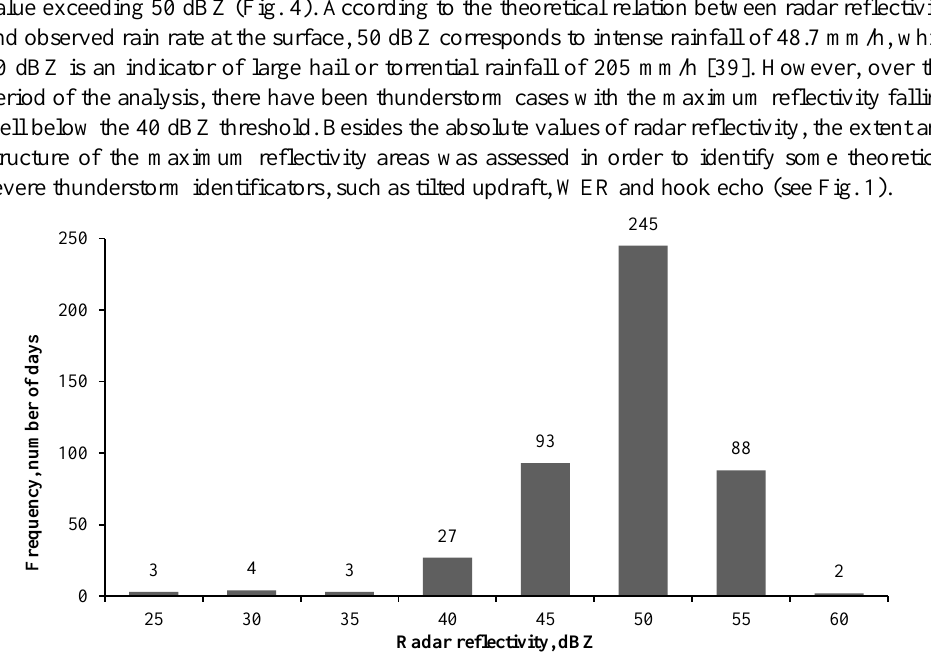
Fig. 4. The frequency distribution of reflectivity values (dBZ) obtained from the weather radar Maximum Display MAX product on days with more than 10 lightning flashes detected in Latvia over the period 2007–2015.